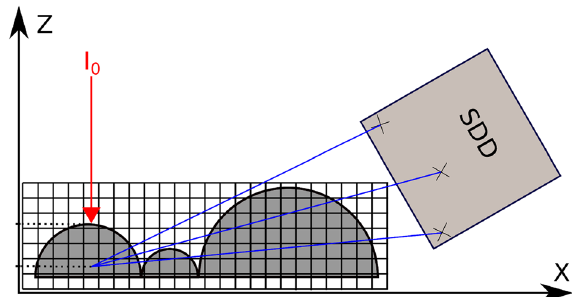
Figure 1. XRF microscopy acquisition setup for a single SDD. The incident beam I 0 (red arrow) invests the sample parallel to the z-axis and travels a distance z before being absorbed, thereby isotropically producing XRF radiation, part of which is directed towards the SDD (blue